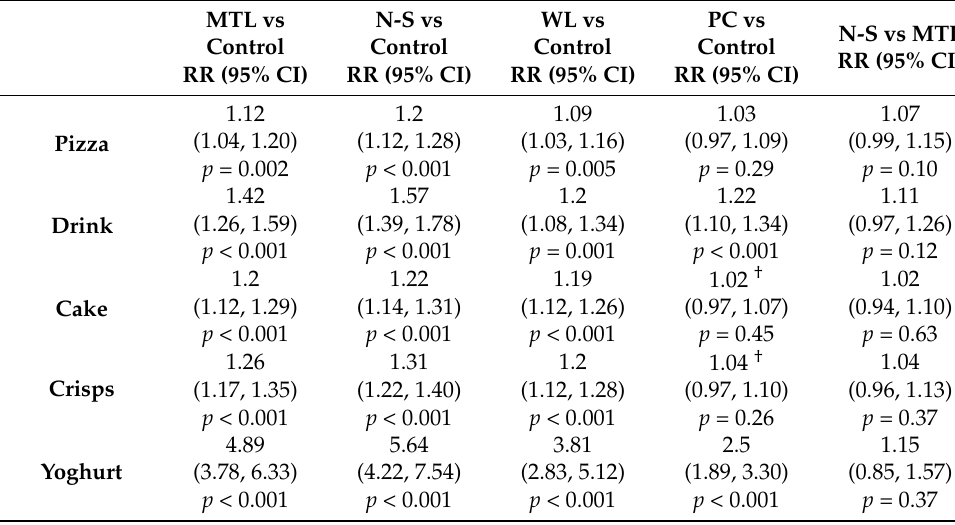
Figure 1. Number of participants who correctly ranked the healthiest product at baseline and follow- up, by FOPL group and product category: ( a ) pizza; ( b ) drink; ( c ) cake; ( d ) crisps; ( e ) yoghurt; ( f ) cereal. † Cake and crisps categories had no products qualify for Positive Choice tick. MTL: Multiple Traffic Lights; N-S: Nutri-Score; WL: Warning Label; PC: Positive Choice tick; FOPL: Front of pack label. Table 2. Multilevel log-binomial regression results—healthiest product ranked correctly (yes/no) at follow-up (adjusted for baseline rank), compared to control by FOPL group (adjusted for design effects and